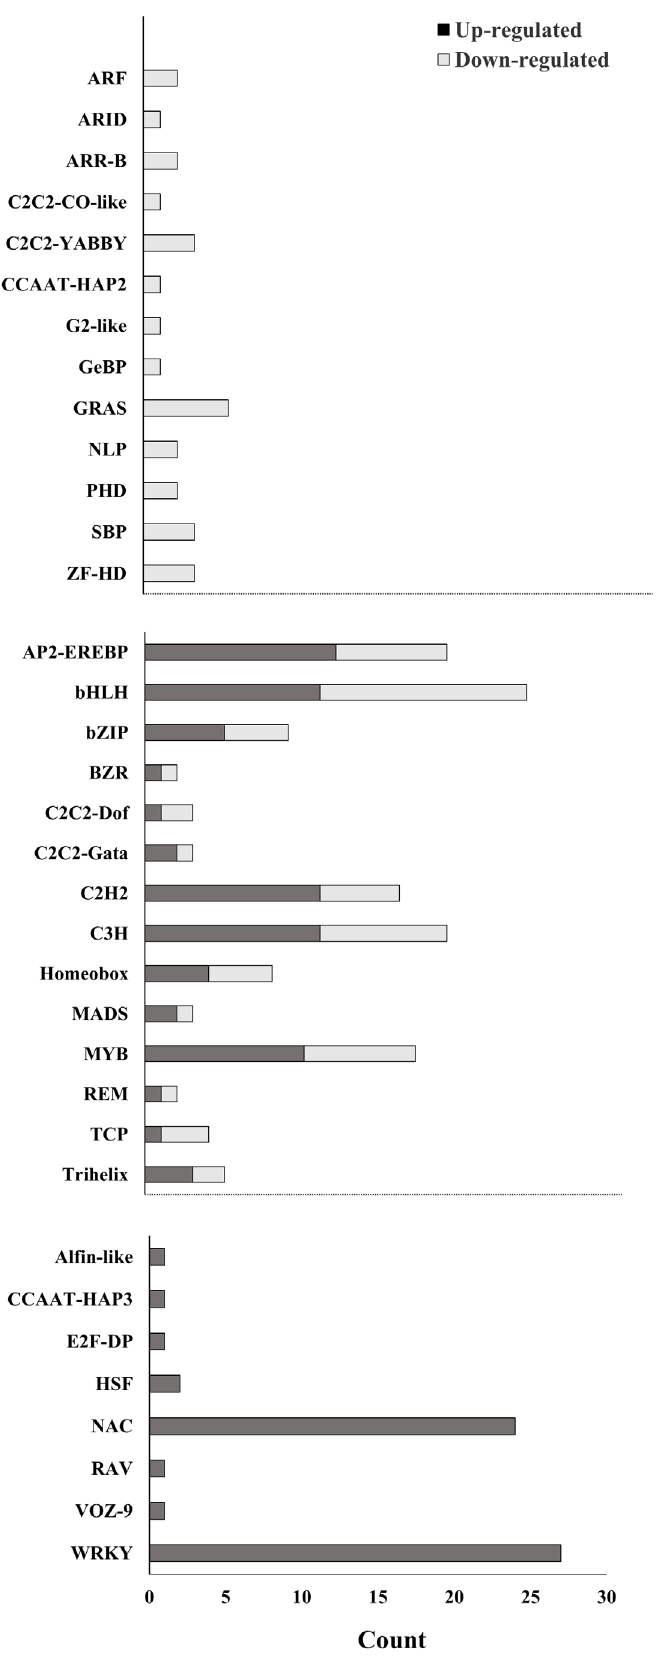
Figure 3. Transcription factors with significant responses to pathogen treatment, indicating direction of change in gene activity: up- regulated (dark grey) ; down- regulated (light grey).